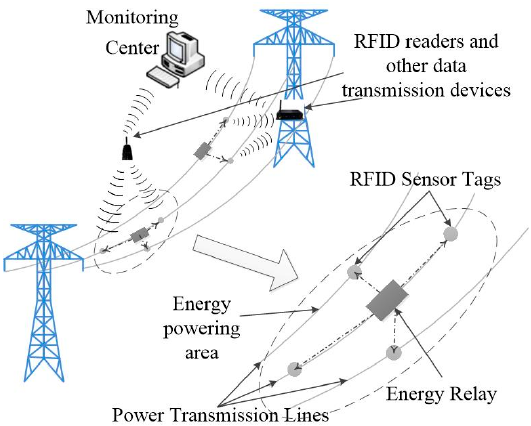
Figure 1. Principle of the proposed relay ‐ powered radio frequency identification (RFID) monitoring networks on power transmission lines.